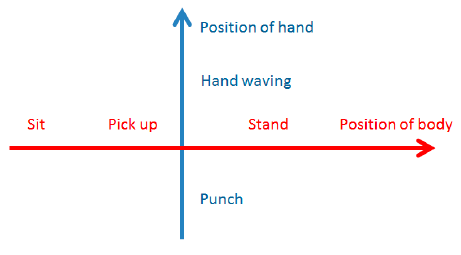
Figure 7. Illustration of classic daily behaviors.